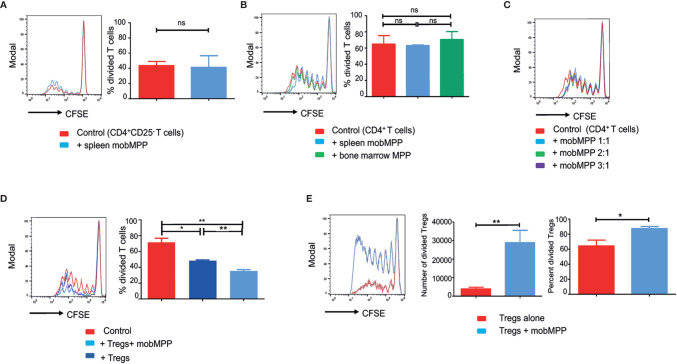
G-CSF-mobilized MPP can suppress MLR by enhancing Foxp3+ Treg proliferation. (A) CFSE dilution was assessed in B6 CD4+CD25− T cell (50,000/well) activated by BALB/c DC (10,000/well) cultured alone (red) or with splenic mobMPP (blue) at a 1:1 ratio (50,000 CD4+CD25− T:50,000 mobMPP/well). Percentage of divided T cells were 43.5± 3.17% in control, versus 41.23± 8.9% in coculture with mobMPP (p = 0.80). Data from 3 independent experiments (n = 3) were compared using Student’s unpaired t-test (ns, not significant). (B) Total B6 CD4+ T cells (containing both CD25− and CD25+ CD4+ T-cells) activated by BALB/c dendritic cells were cultured alone (red), with splenic mobilized MPP at a 1:1 ratio (light blue), or with non-mobilized bone marrow MPP at a 1:1 ratio (green). Percentages of divided T cells were 64.88± 10.48% in control, versus 63 ± 1.30% and 70.43 ± 17.19% in coculture with mobMPP (p = 0.87) or bone marrow MPP (p = 0.73), respectively. Data were compared using one-way ANOVA with Tukey’s multiple comparison test (ns, not significant). (C) Total B6 CD4+ T cells (containing both CD25− and CD25+ CD4+ T-cells) CFSE dilution is similar when B6 CD4+ T cells activated by BALB/c DC were cultured alone or with mobMPP at 1:1 ratio (50,000 CD4+ T cells:50,000 mobMPP/well). A higher number of MobMPP in the well (1:2 ratio (50,000 CD4+ T cells: 100,000 mobMPP/well), or 1:3 ratio (50,000 CD4+ T cells: 150,000 mobMPP/well) does not impact total B6 CD4+T cell proliferation (one experiment, n = 1). (D) B6 CD4+CD25−CD45.1 T cells activated by BALB/c DC were cultured alone (red) or with CD45.2 Tregs at a 1:1 ratio (dark blue), or with CD45.2 Tregs and CD45.2 mob-MPP at a 1:1:1 ratio (light blue) (n = 3). Percentages of CD45.1 divided T cells were respectively 71.54 ± 5.27% in control, 48.52 ± 0.86% in the presence of Tregs, (p = 0.0125, *) and 35.49 ± 1.66% with both Tregs and mobMPP, (**p = 0.0028). The percentage of divided T cells was higher when both Tregs and mobMPP were present, rather than Tregs alone (**p = 0.0023). Data were compared using Student’s unpaired t-test (ns, not significant). (E) B6 Treg cells activated with allogeneic BALB/c DC were cultured alone (red) or with mobMPP (blue) (n = 11). The number of Tregs in proliferation (≥ division 1) is lower when Tregs are cultured alone (3918 ± 905 vs. 28792 ± 6659, **p = 0.0014). Percentages of Tregs in proliferation (≥ division 1) are also lower when Tregs are cultured alone (64.28 ± 25.66% vs. 87.40 ± 9.26%, *p = 0.0108, using Student’s unpaired t-test).